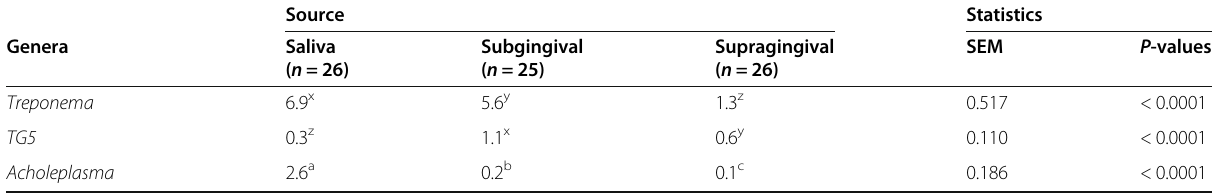
Table 3 Oral bacterial genera (relative abundance, %) present in plaque (supragingival and subgingival plaque) and saliva samples from healthy adult dogs (Continued)